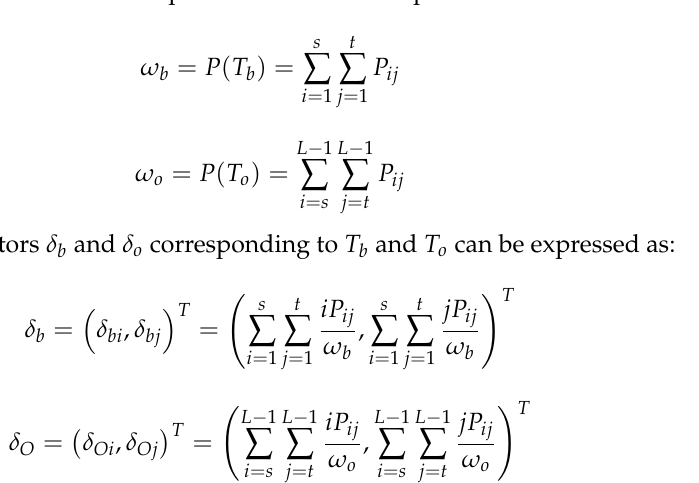
Figure 3. Planar projection of two-dimensional gray histogram. For the space target images, the gray value of the pixel inside the target is roughly the same as the neighborhood mean gray level, and so is the gray value of the spatial background. However, the gray values at the edges of the target and the noise are different. For a given threshold pair ( s , t ) , image pixels can be divided into two groups, background T b and objects T o . Their occurrence probabilities can be expressed